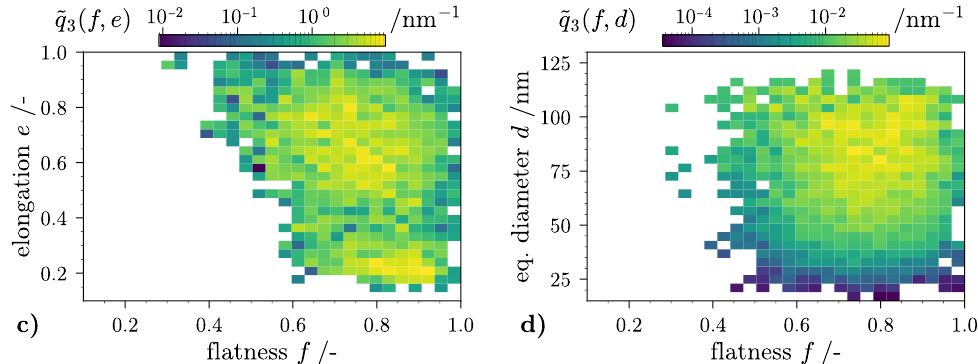
Figure 8. ( a ) Three dimensional (3D) particle trait distribution (PTD) ˜ q 3,in ( f , e , d ) of virtual silicon dioxide (SiO 2 ) particle system: discretization over the three distinct traits d, e and f; ( b – d ) Marginal- ized distributions ˜ q 3,in visualized in a two dimensional (2D)